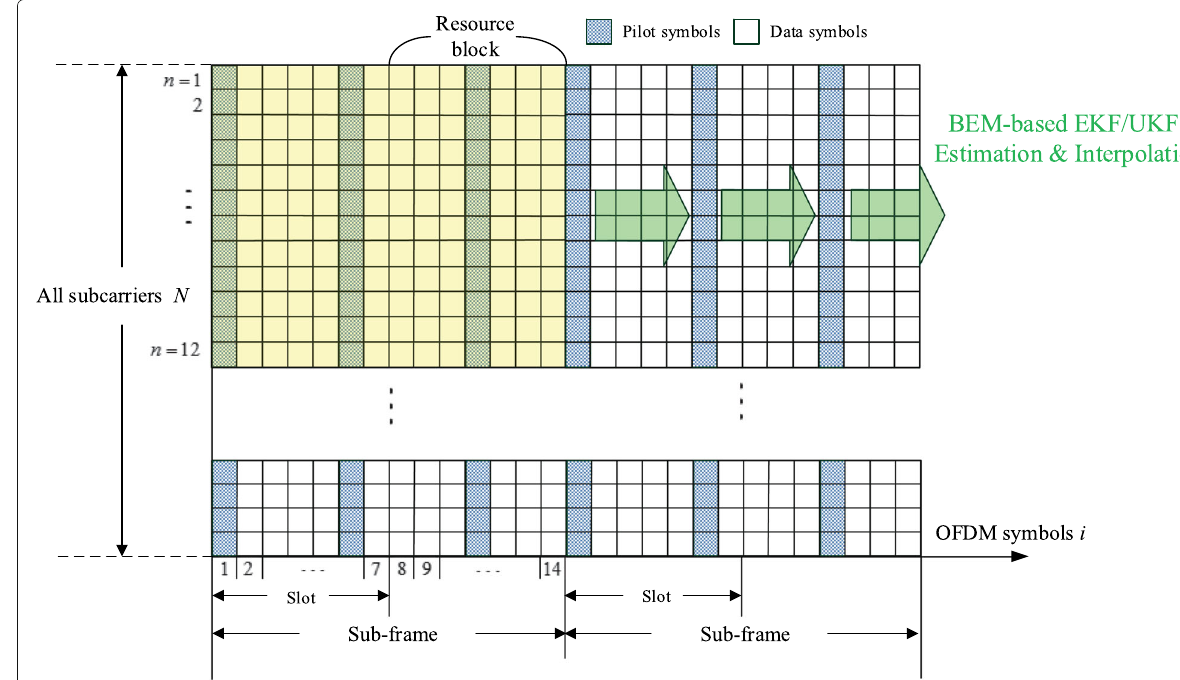
Fig. 3 Frame structure and pilot pattern. OFDM communication system based on block pilot satisfies the needs of modern wireless communication